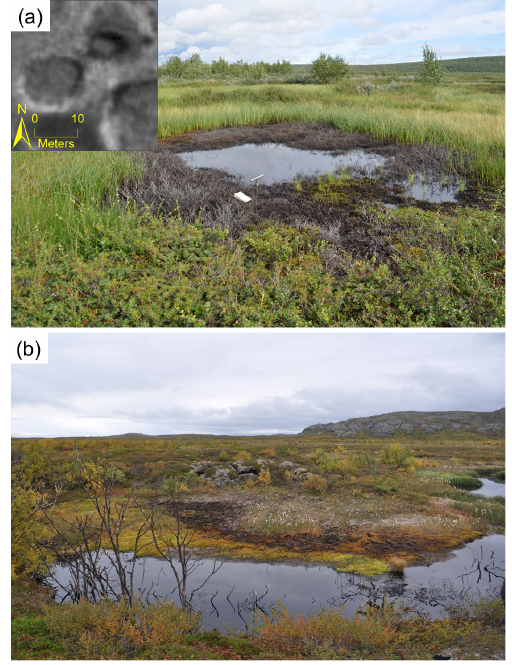
Figure 2. (a) Small thermokarst lake with recently dead vegetation at palsa mire 7 in Suossjavri, August 2014, situated at the location of a former small palsa (visible in aerial image from 2003, see in- let). (b) Degrading palsa and recently submerged birch trees at palsa mire 2 in Karlebotn, September